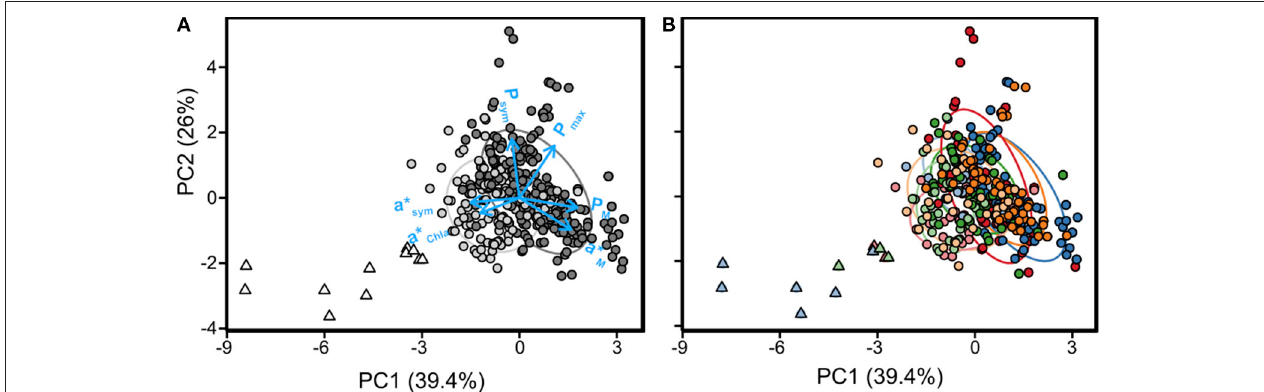
FIGURE 5 | Principal component analysis (PCA) plot showing (A) the grouping of samples in un-stressed (dark gray), stressed (gray), and bleached (light gray) coral phenotypes, based on the optical (a * Chl a , a * sym , a * M ) and photo-physiological (P max , P sym , P M ) descriptors. Blue arrows indicate the correlation of the different descriptors with PC1 and PC2. Plot (B) described the same grouping identifying coral species with different color: Orbiella annularis in blue, Orbicella faveolata in orange, Montastraea cavernosa in green, and Pseudodiploria strigosa in red. Different shading describes coral phenotypes from unstressed (dark) to bleached (lighter).